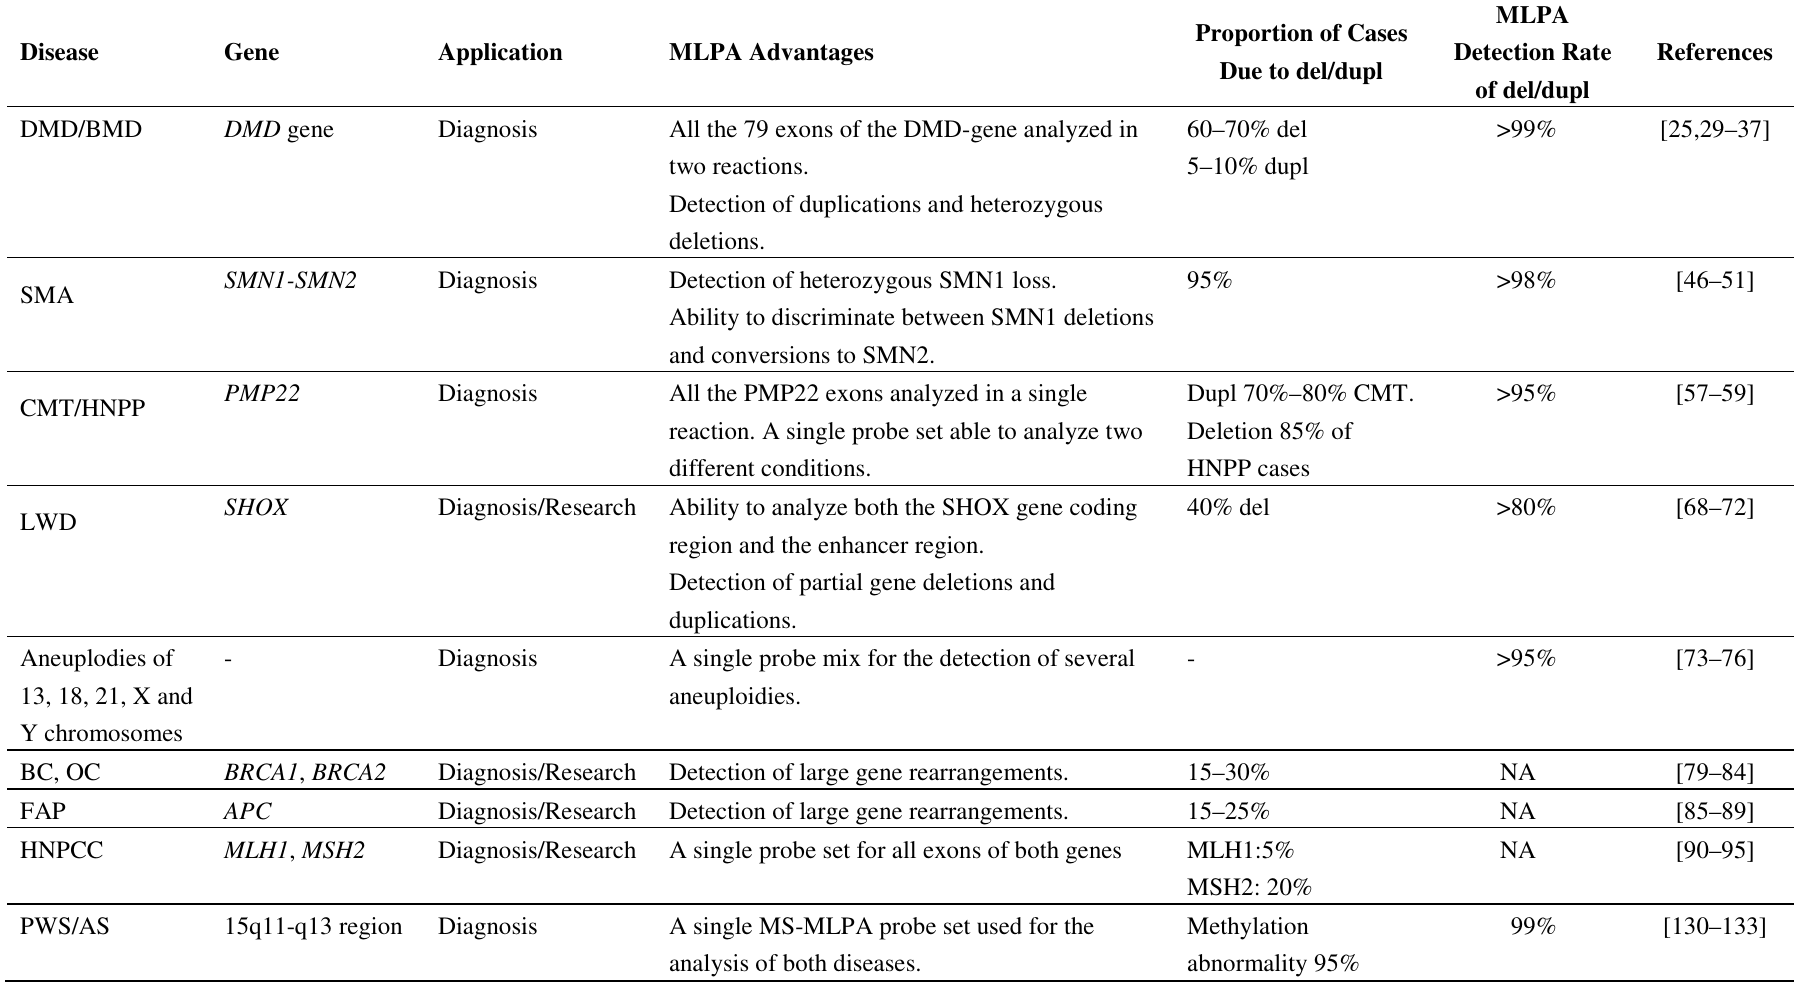
Table 2. MLPA applications as diagnostic and discovery